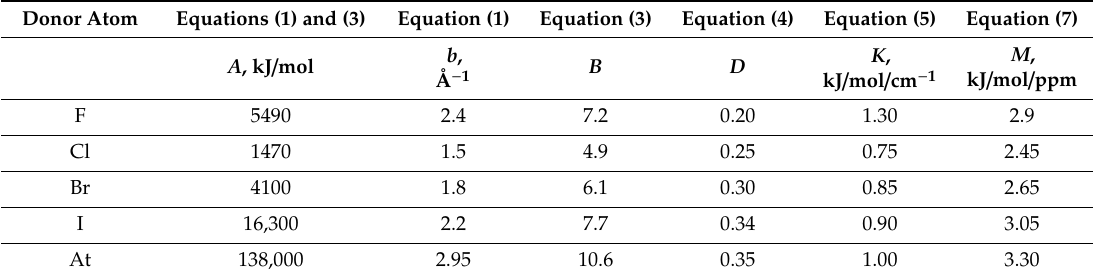
Table 1. The numerical values of fitted parameters A , b , B , D , K and M used in Equations (1)–(6). The resulting curves are shown in Figures 4–7.